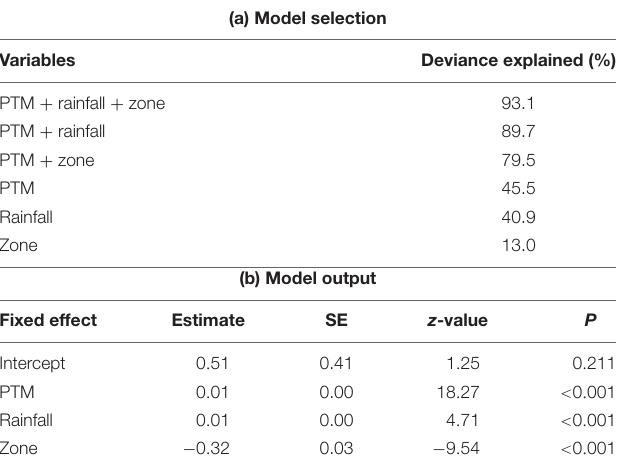
TABLE 2 | Model selection based on explained deviance related to the inclusion of different predictors: Particle Tracking Model (PTM) outputs, rainfall and beach longshore zonation to explain rates of observed input of microplastic pellets to the open coastal beaches of Santos